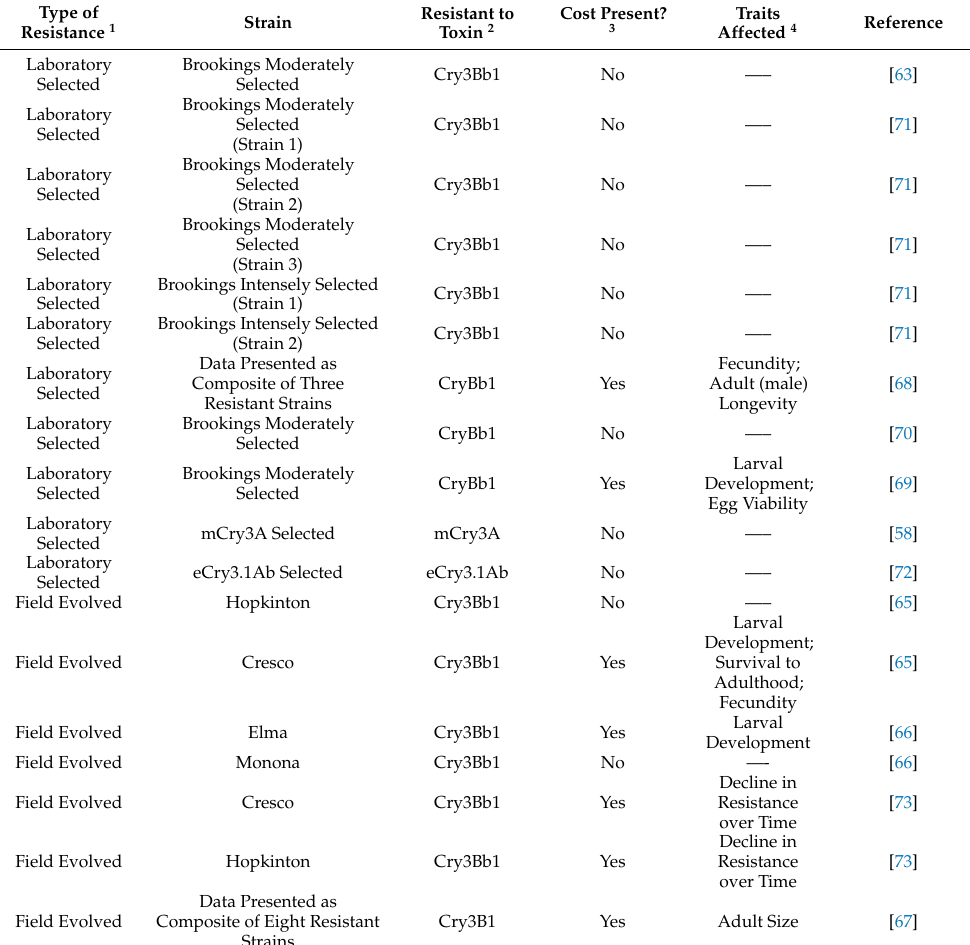
Table 2. Studies testing for fitness costs of resistance to Bt maize by western corn